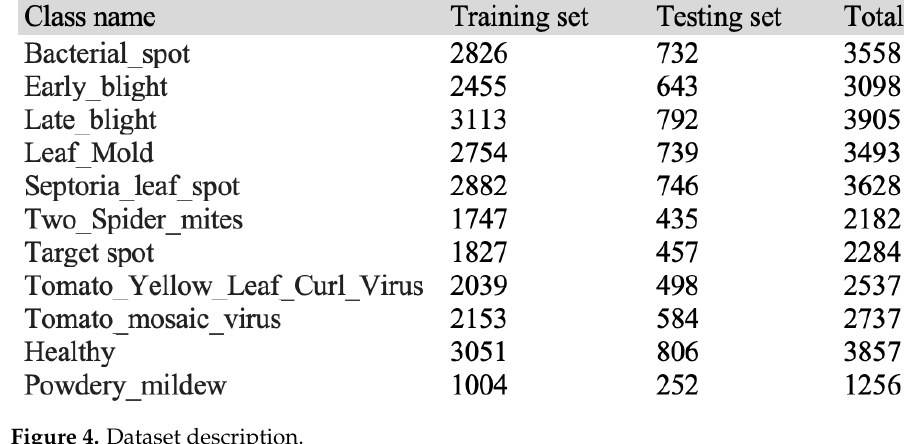
Figure 5. Image distribution per class in the training set.